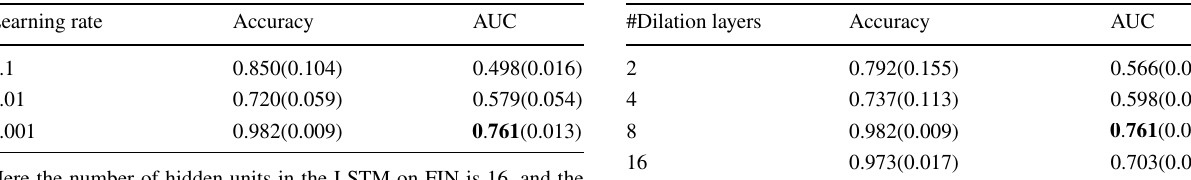
Table 5 The results of different learning rates in DMDP with LSTM (FIN) + Wavenet (TEXT)